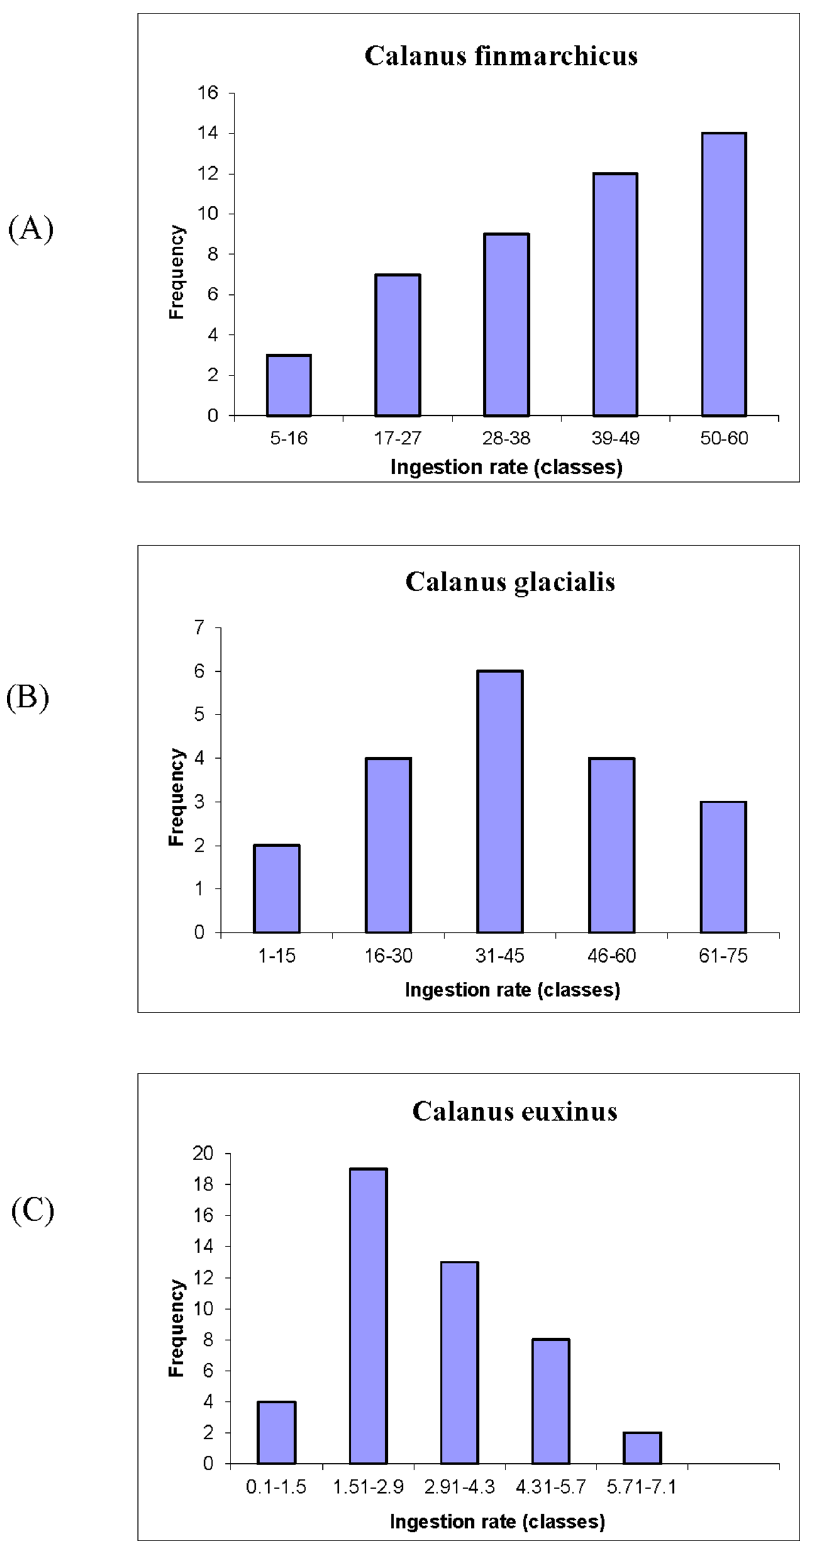
Figure 1. Individual ingestion rates of the three different Calanus . species measured in the laboratory. The number of feeding sessions is 5, 6 and 6 for C. finmarchicus , C. glacialis , and C. euxinus , respectively. One can observe a pronounced variation of ingestion rates, which can be estimated by computing the coefficient of variation defined as CV = s /m (in all cases the calculation gives CV < 0.5).